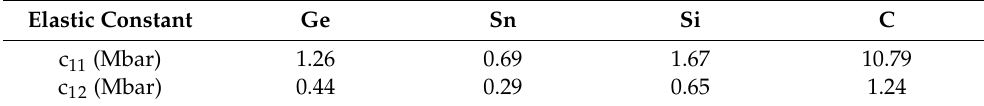
Table 2. Elastic constants of the group IV elements [50,51]. Elastic Constant Ge Sn